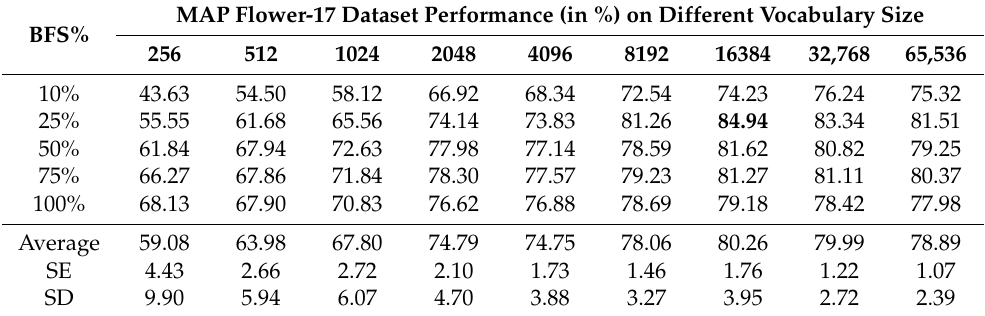
Table 8. The KFFVW Performance with various vocabulary sizes and BFS on Oxford Flower-17. MAP Flower-17 Dataset Performance (in %) on Different Vocabulary Size BFS%